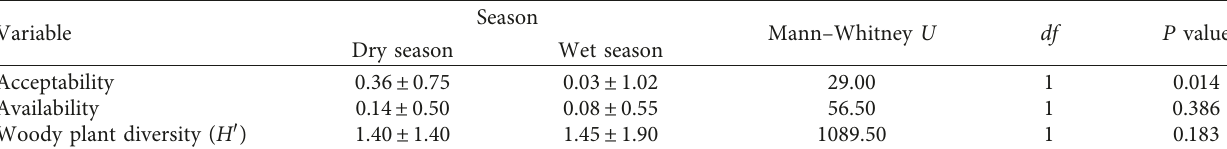
Table 2: Forage indices and species diversity (median ± range) of woody plants selected by giraffes in the wet and dry season in Umfurudzi